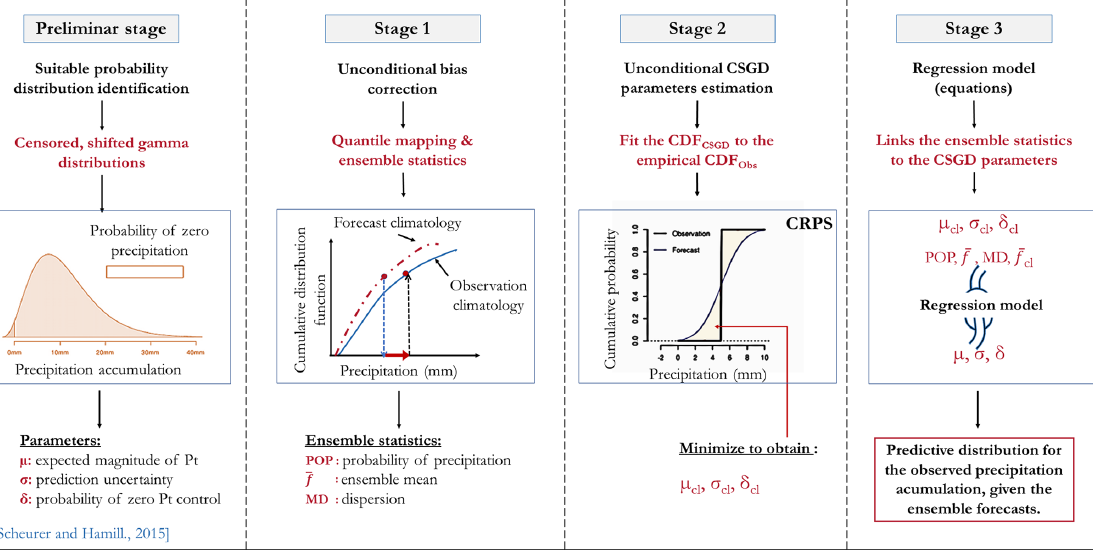
The EnKF performance is highly sensitive to its hyperpa- rameters (Thiboult and Anctil, 2015), which represent the un- certainty around hydrological model inputs and outputs. For precipitation, we used 50 % standard deviation of the mean value with a gamma law. For streamflow and temperature, we used 10 % and 2 ◦ C standard deviation with normal distribu- tion,